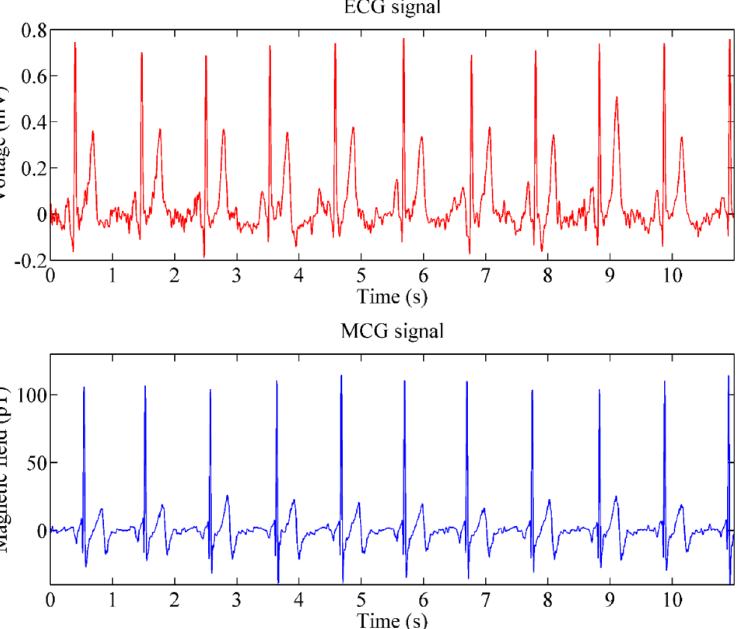
Figure 2. From top to bottom are ECG signals and MCG signals processed by digital filtering. The y-axis represents the magnetic field strength in units of pT, and the x-axis represents the sampling time in units of s.